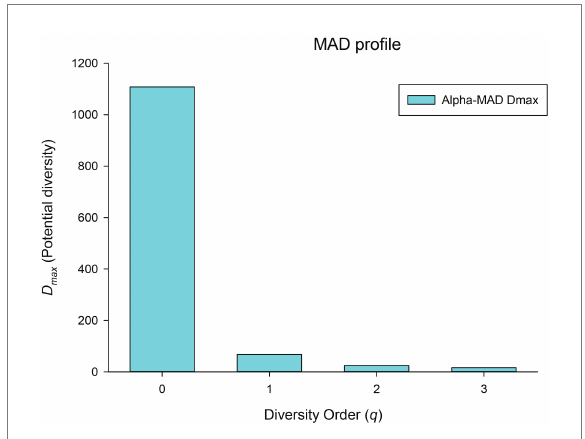
FIGURE 4 The MAD profile (D max -q) of the human breast milk microbiome in healthy women.